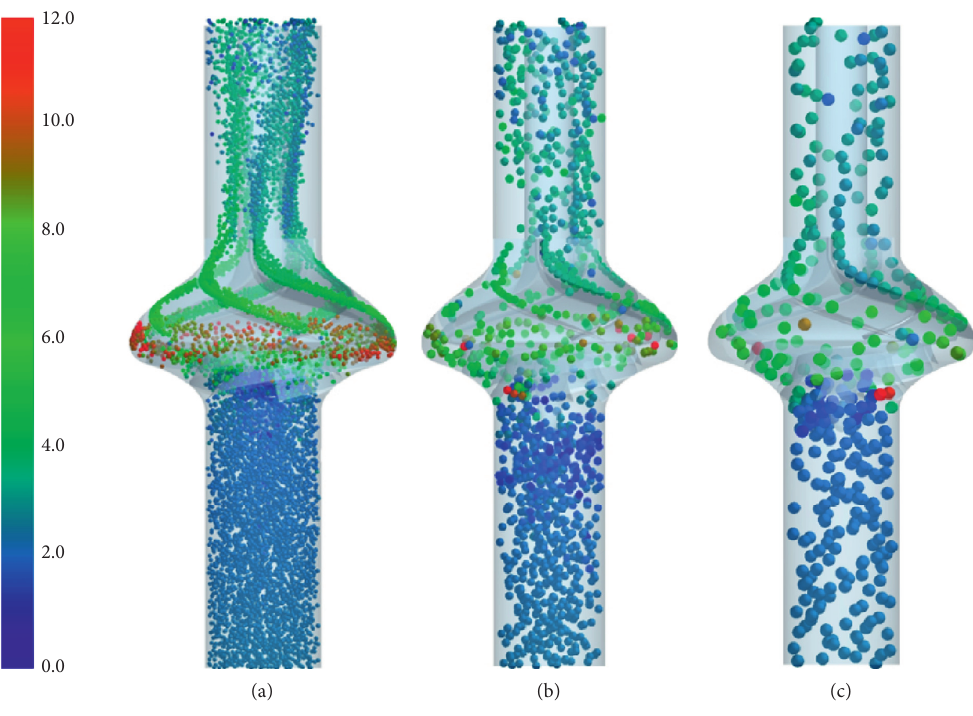
Figure 7: Particle volume distribution of the whole flow domain: (a) 5mm, (b) 10mm, and (c) 15mm.